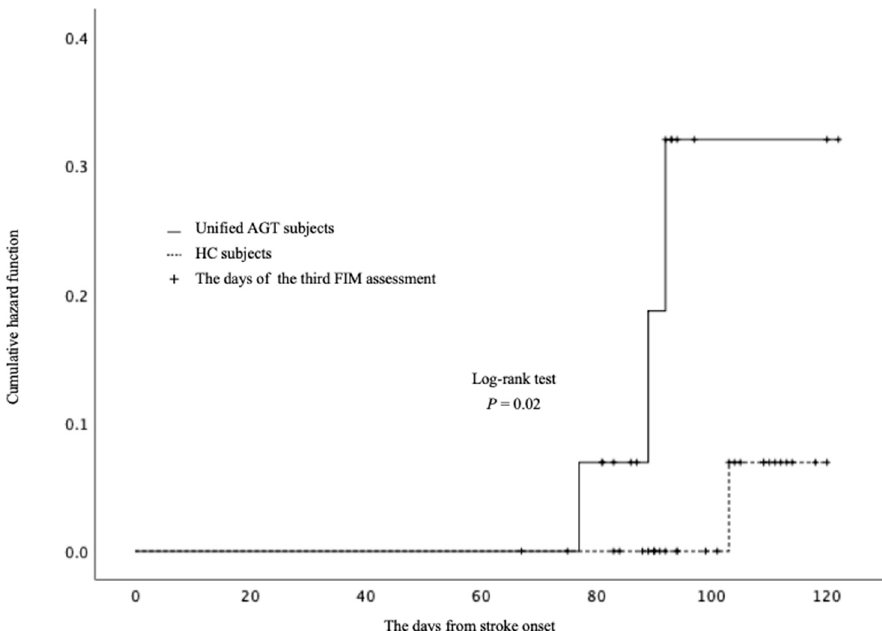
Figure 4. Survival analysis for reaching FIM gait score of 4. The vertical axis represents the cumulative hazard function of reaching an FIM gait score of 4 points. The horizontal axis represents the days from stroke onset. Solid line: AGT subjects; dashed line: HC subjects. Survival analysis indicated that the AGT subjects reached an FIM gait score of 4 quicker than the HC subjects during the FIM assessments period (nearly 12 weeks) following admission.